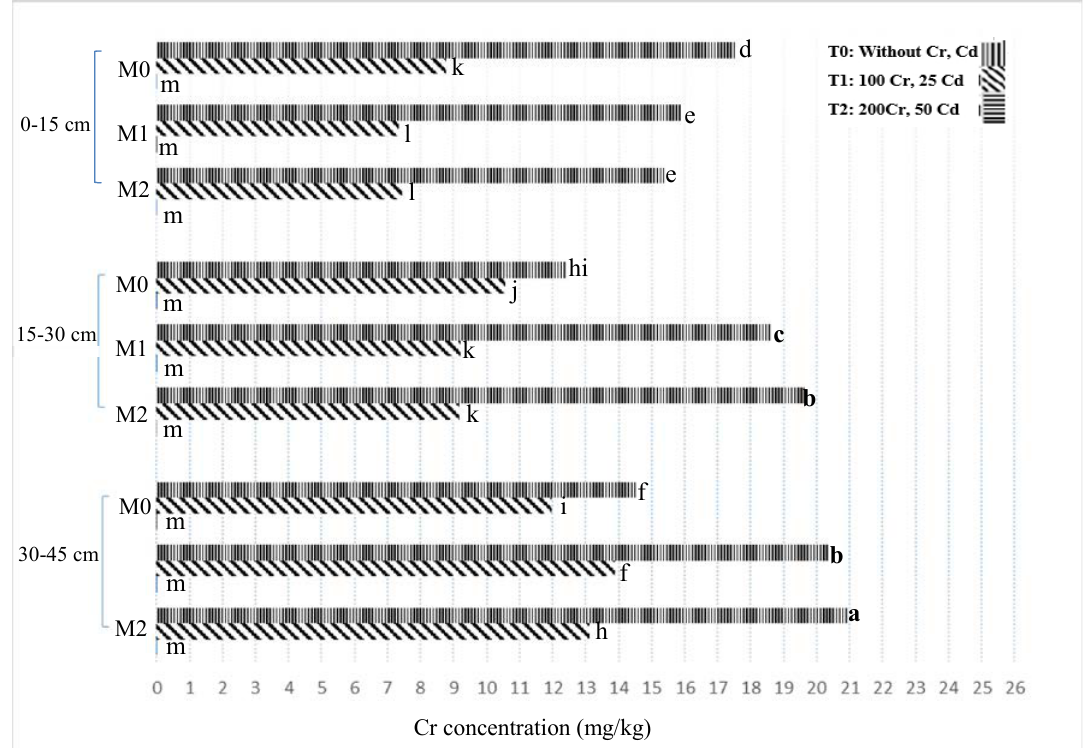
Cr concentration (mg/kg) Fig. 2: Effects of compost and humic acid on Cr concentration in the soil column. Values are means (n = 3). Similar letters are not significantly different at P<0.05 , according to Duncan’s test. M0: without organic substance, M1: compost, M2: Humic acid.